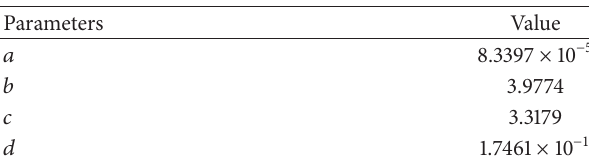
Table 3: Regression parameters.